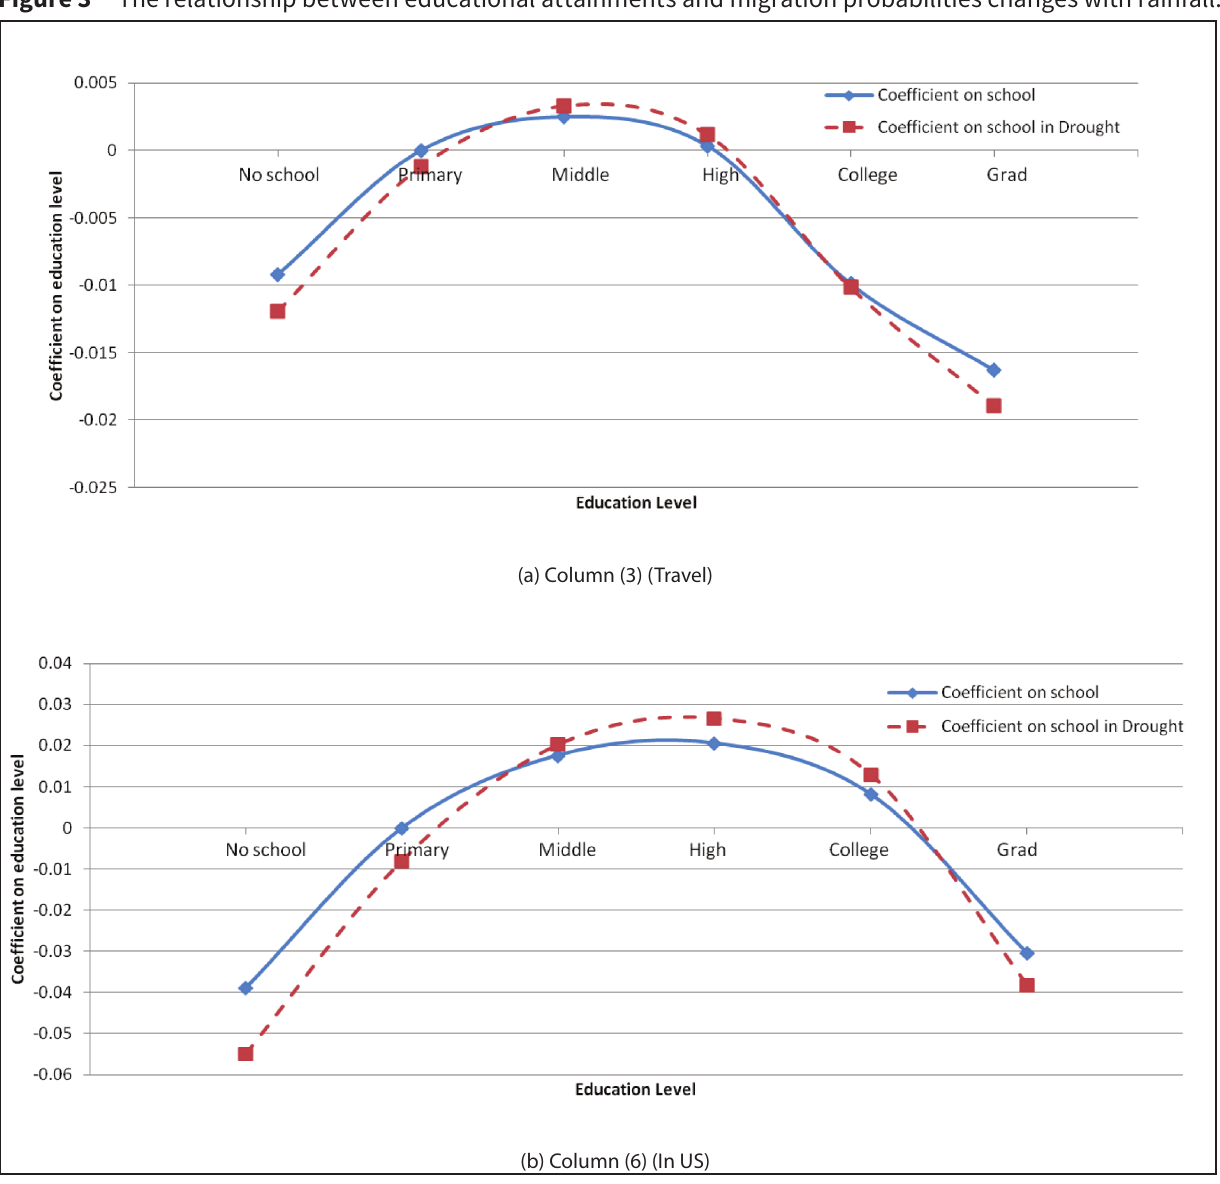
Points on the solid line represent the coefficients on educational categories based on the migration regression results in Table 5. Points on the dashed line represent the changed coefficients on educational categories caused by a decrease in rainfall (439 mm). Both (a) and (b) show an inverted U relationship between migration probabil- ities and educational attainments. When rainfall decreases, people in categories Middle and High have higher probabilities to travel to or stay in the US, while people in categories No school, Primary, and Grad reveal lower migration